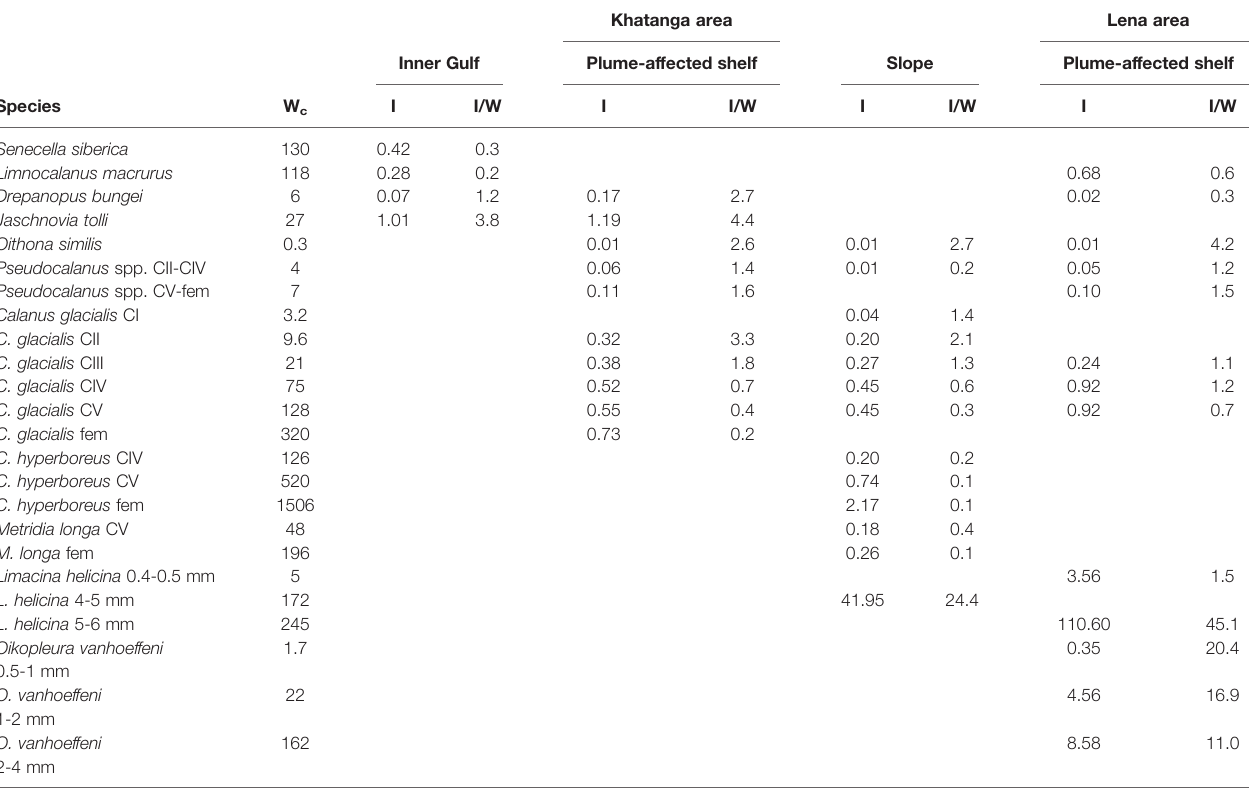
TABLE 4 | Daily ingestion of autotrophic phytoplankton (I, m g C ind -1 d -1 ) and speci fi c daily ration (I/W, % body carbon) of the dominant zooplankters in different habitats.